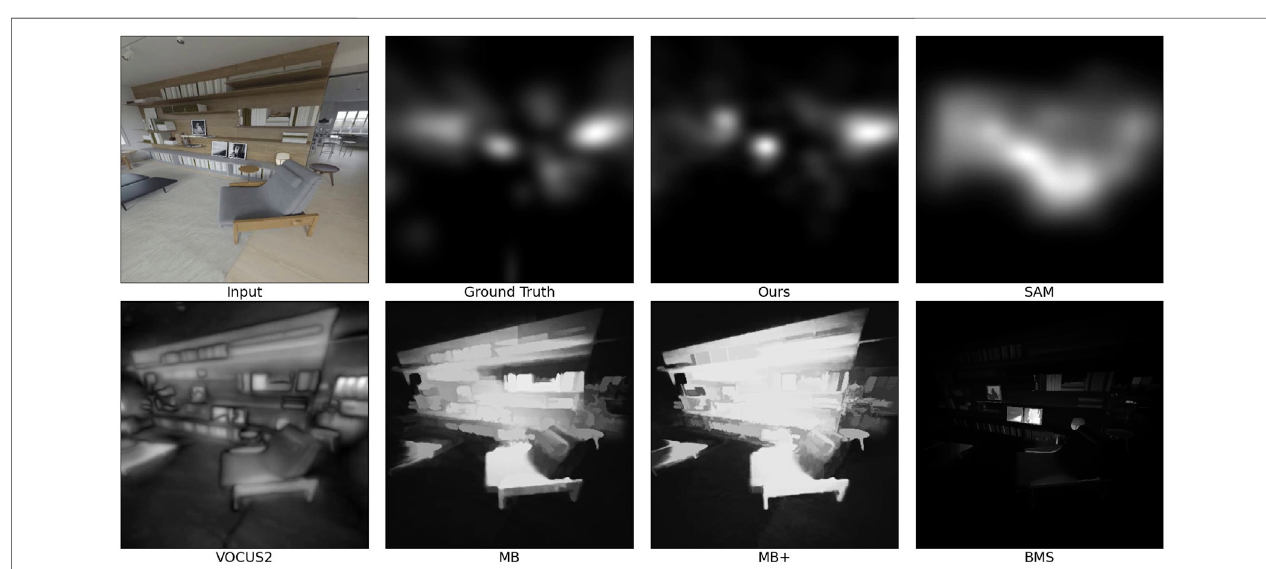
FIGURE 5 | Qualitative example showing the output of the evaluated saliency predictors along with the ground truth and our approach on the Saliency in VR dataset. Our method uses the eye fi xations from other users and maps them to the current view, without using the fi xations from the current user, while the standard saliency predictors compute saliency based on the current